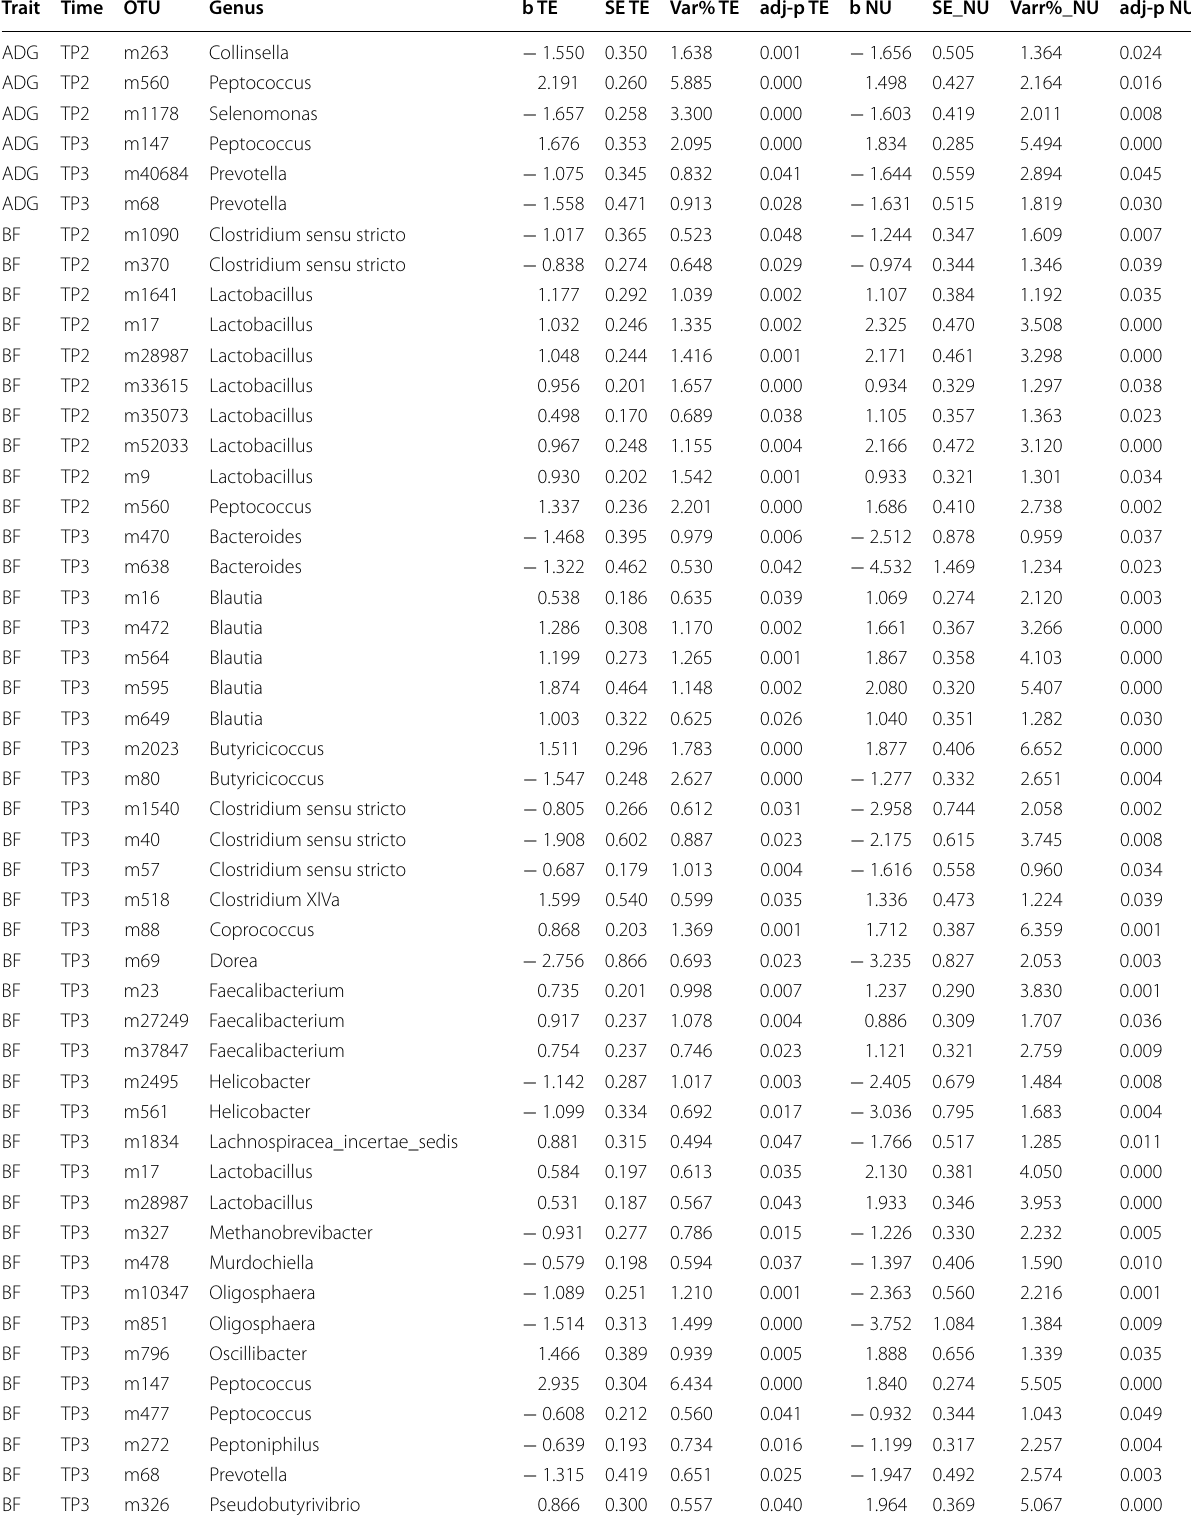
Table 2 Summary of OTUs significantly associated with growth traits in two systems Trait Time